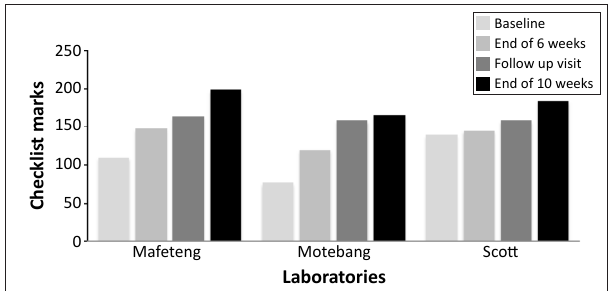
FIGURE 2: Performance of the three district laboratories at baseline, end of six weeks, beginning of four weeks follow-up visit and at 10 weeks using the SLIPTA checklist.